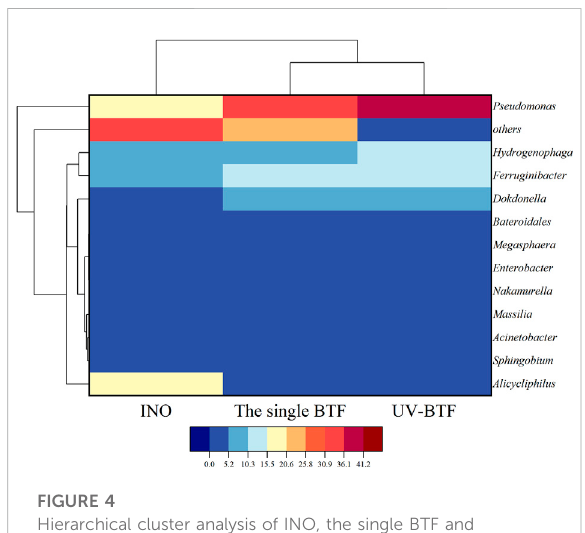
FIGURE 4 Hierarchical cluster analysis of INO, the single BTF and combined UV-BTF bacterial